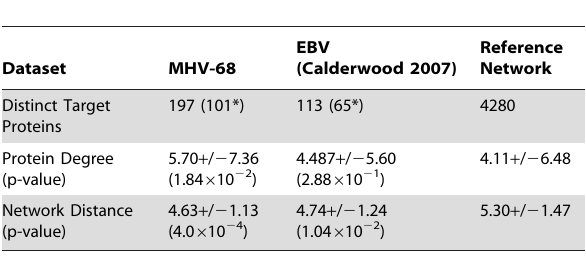
Table 1. Network properties of cellular proteins that interacted with MHV-68